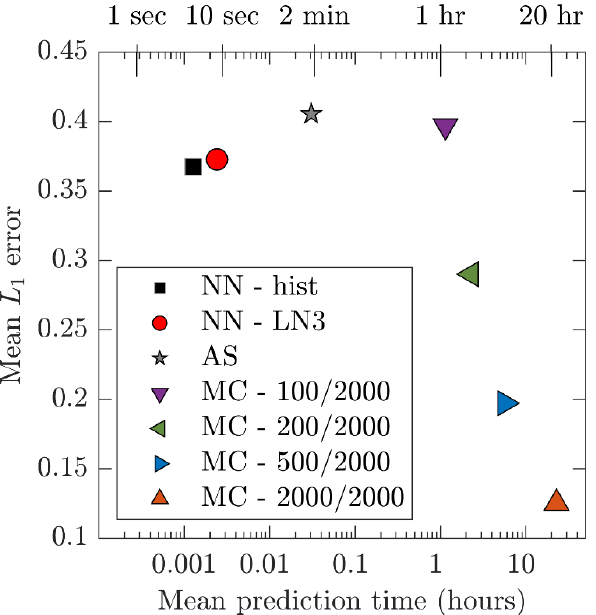
Figure 11. Comparison of the mean testing errors and TL PDF prediction times for each method. The mean prediction time is the average of the 100 testing case prediction times—the time it took to predict the PDF of TL for every example in that case after the baseline TL computation was available.